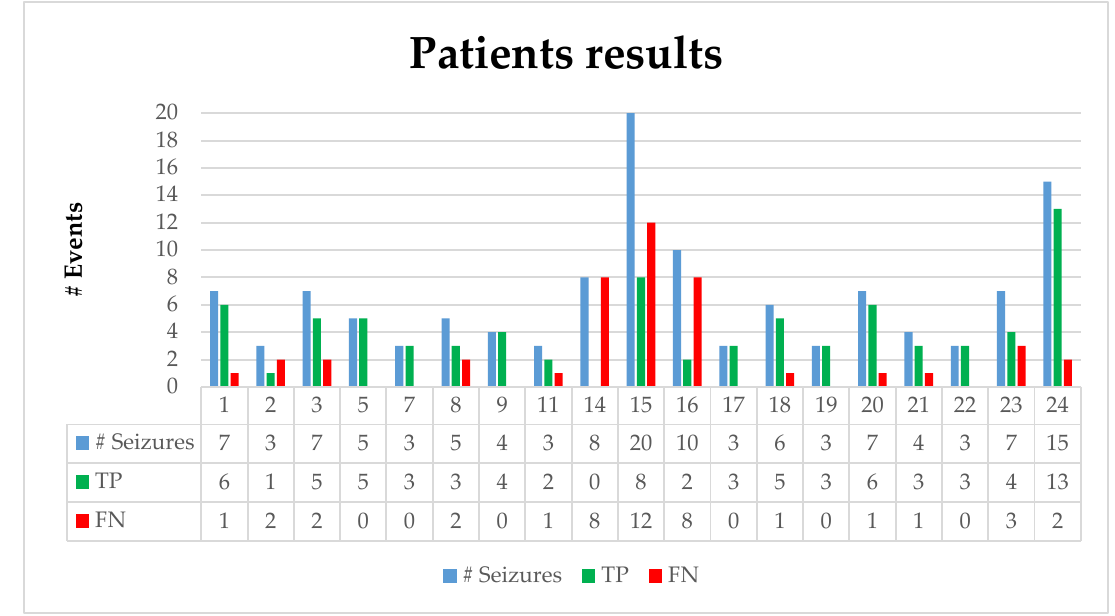
Figure 5. Results of the CHB-MIT dataset contains the number of seizures, the true positives (TP), and false positives (FP) for each patient.